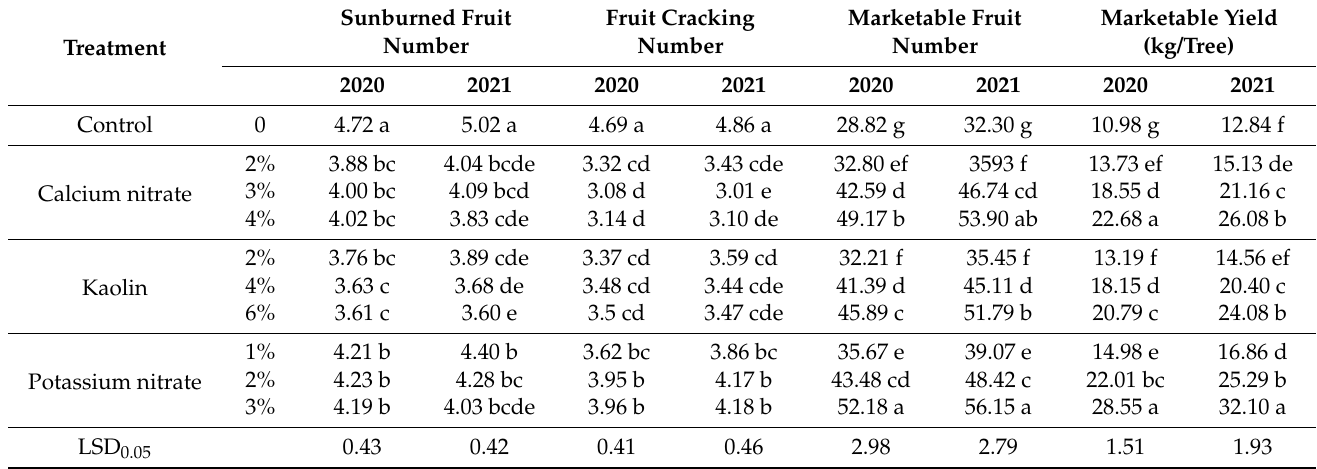
Table 3. The effect of the foliar application of potassium nitrate, calcium nitrate and kaolin on the numbers of fruit sunburned, fruit cracking and marketable fruit of the ‘Wonderful’ pomegranate variety during the 2020 and 2021